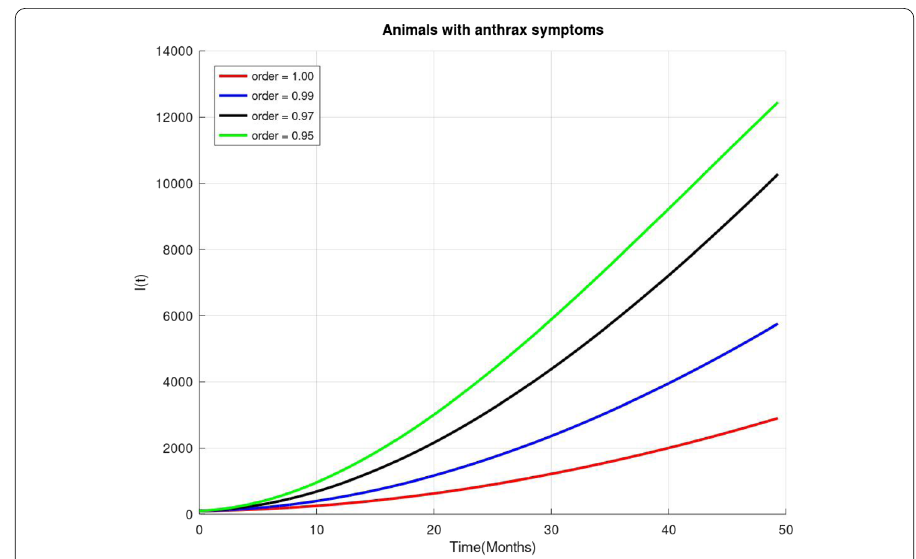
Figure 3 An illustration of the total number of infected animals I ( t ) for different orders (cid:2) = 1, (cid:2) = 0.99, (cid:2) = 0.97, and (cid:2) = 0.95 during 50 months